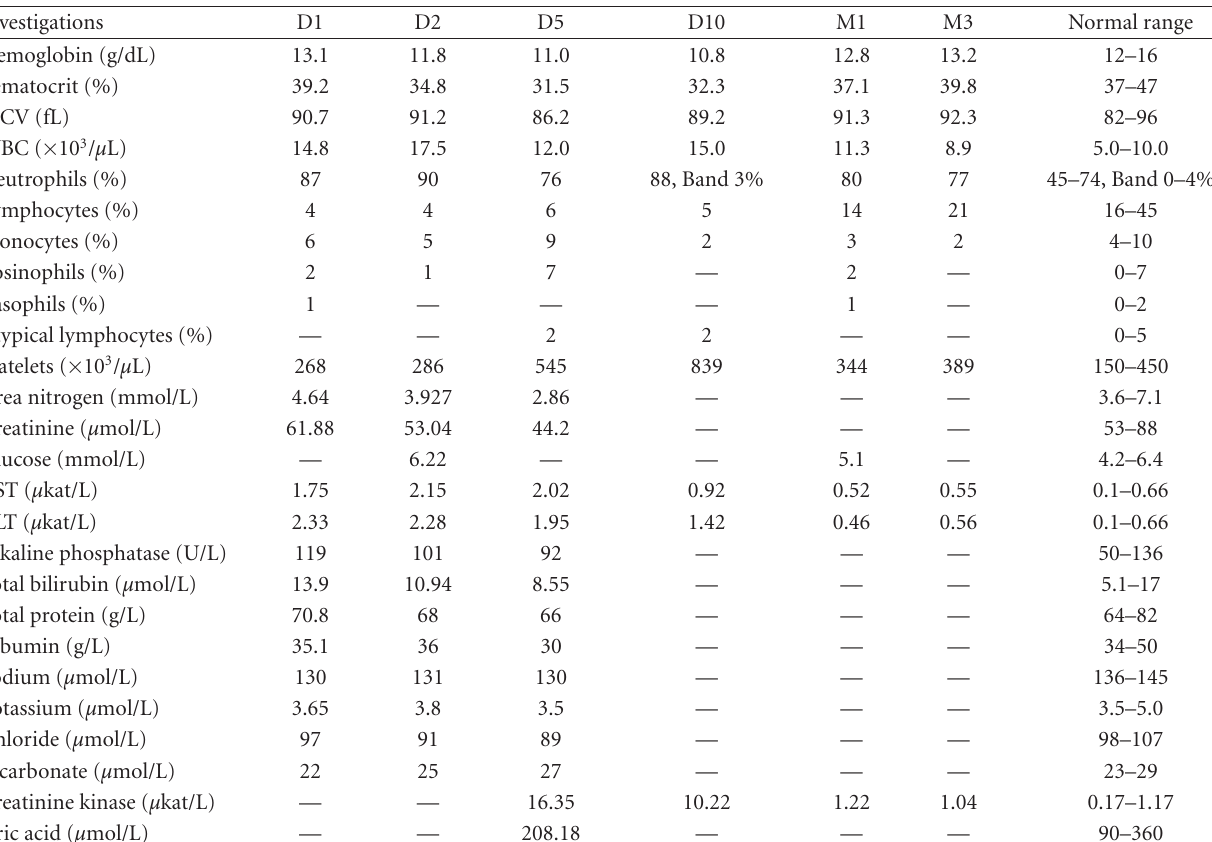
Table 1: Summary of laboratory